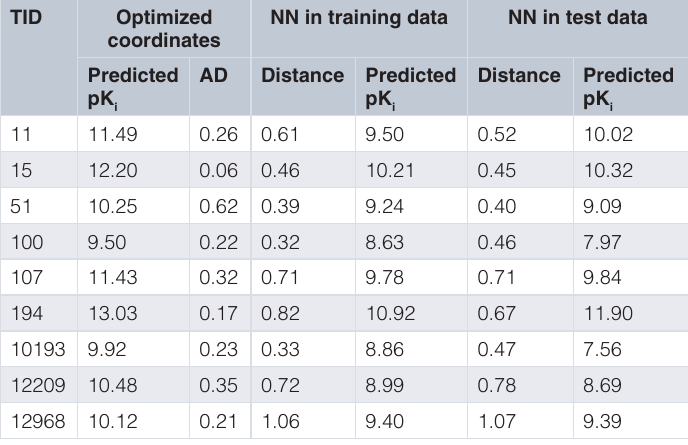
Table 4. Optimized coordinates and nearest neighbors. For optimized coordinates, the predicted